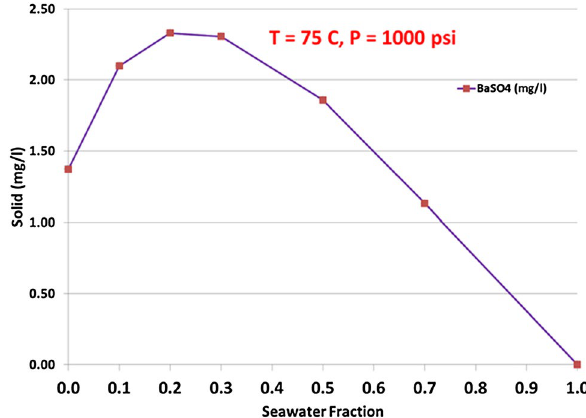
Fig. 3 Micrograph of detected sulfates in the water mix (1:1)